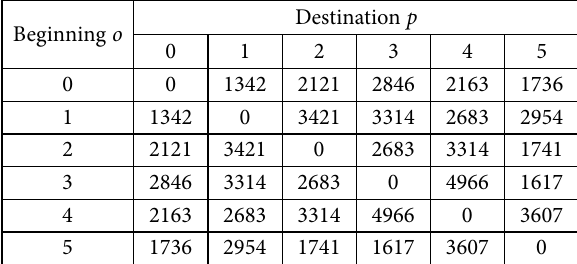
Table 6. The distance (cost of traveling) between zones for NE 2